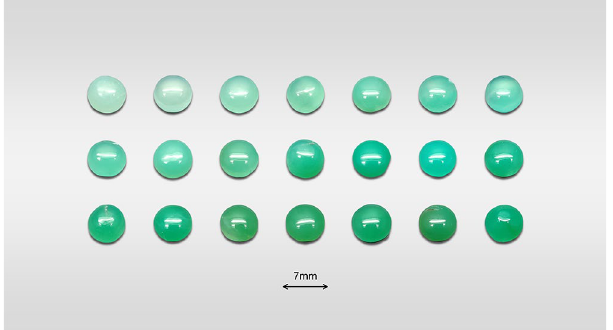
Figure 1. Photograph of some of the samples used in the present study. The round flat samples used for colour- parameter testing had an average mass of 3.96